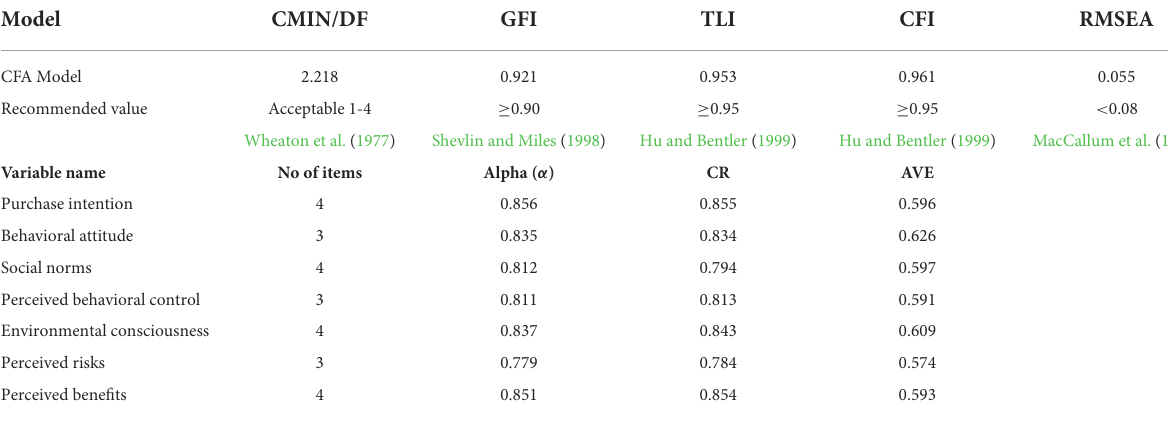
TABLE 2 CFA model fit Indices, Alpha, CR, and AVE.